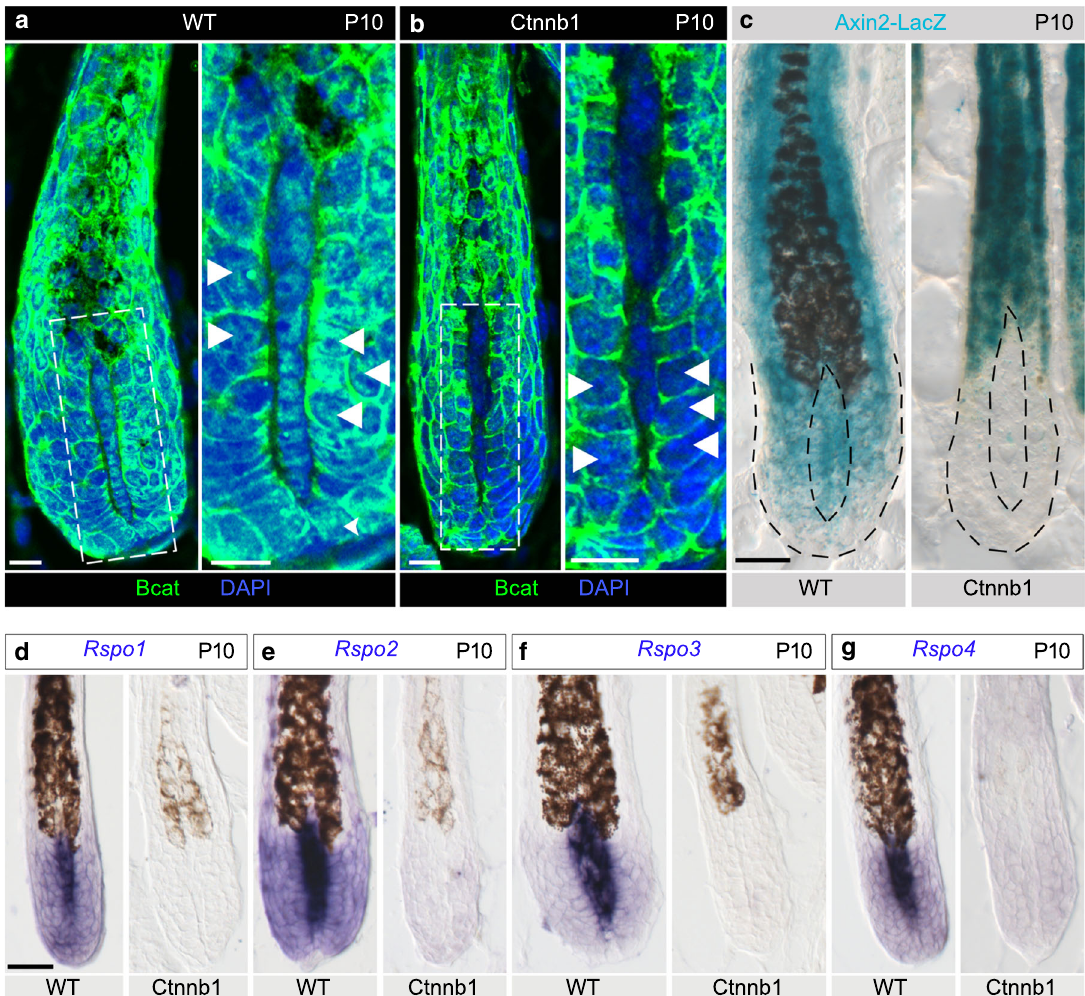
Fig. 6 Ablation of beta-catenin speci fi cally in the DP results in reduction of Wnt signaling activity in the matrix. a Immunostaining for beta-catenin during mid anagen (P10) of a wild-type follicle is displayed. Nuclei are in blue (DAPI). A higher magni fi cation of the fi eld outlined with the dashed white square in the left panel is presented on the right panel. Note that in addition to the membrane localization of beta-catenin in matrix cells, activated beta- catenin is readily detected also in the nuclei of these cells (white arrowheads). n = 3 mice. b beta-catenin mutant mice were used to immunostain for beta- catenin at P10 to illustrate the ef fi cient deletion of beta-catenin in the DP and the dramatic reduction of nuclear beta-catenin in matrix cells (white arrowheads). A higher magni fi cation of the fi eld outlined with the dashed white square in the left panel is shown on the right panel. n = 3 mice. c X-Gal staining in skin sections from P10 wild-type (left panel) and mutant (right panel) littermates demonstrates that Wnt activity in the mutant is abolished in both the DP and matrix. The internal dashed black line outlines the DP and the external black dashed line demarcates the follicle boundaries. n = 3 mice per genotype. d – g In situ hybridization for Rspondins on skin sections from P10 wild-type and mutant littermates illustrates the absence of Rspondin transcripts in both the DP and matrix of the mutant. n = 3 mice per genotype. Scale bar in ( a , b ), 10 μ m. Scale bar in ( c – g ), 25 μ